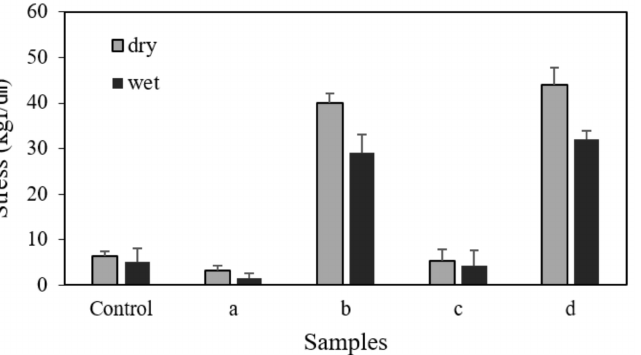
Figure 5. Tensile strength of control sponge, ( a ) Alg-CMC ratio (5:5); ( b ) Alg-CMC ratio (5:5) with dextran; ( c ) Alg-CMC ratio (7:3); ( d ) Alg-CMC ratio (7:3) with dextran ( n = 3, mean ±